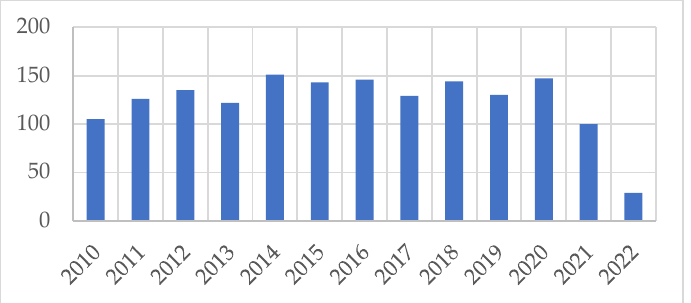
Figure 1. Distribution of reports by year.